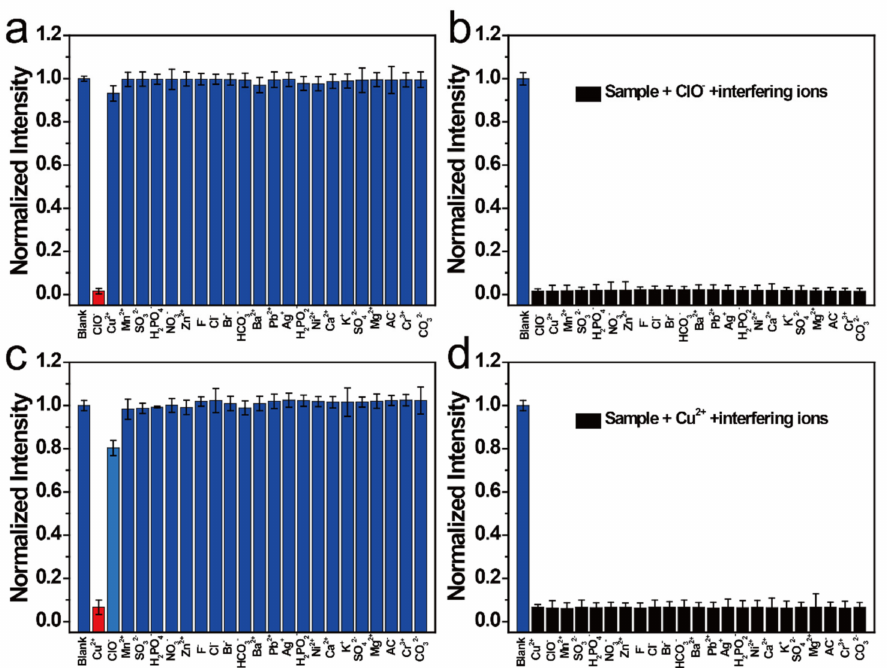
Figure 3. ( a ) Normalized FI of NCDs after the addition of various ions. ( b ) Normalized FI of ClO − - NCDs after the addition of various ions. ( c ) Normalized FI of NCDs after the addition of various ions. ( d ) Normalized FI of Cu 2+ -NCDs after the addition of various ions.